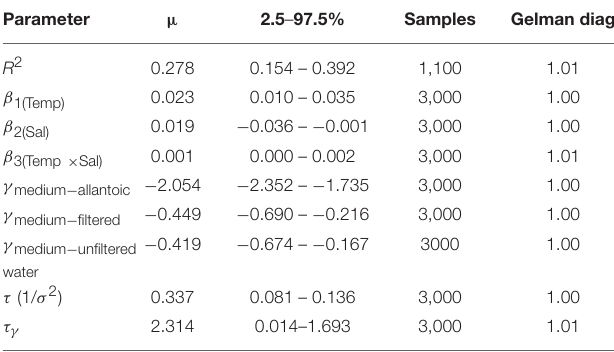
TABLE 1 | Parameter estimates of the selected